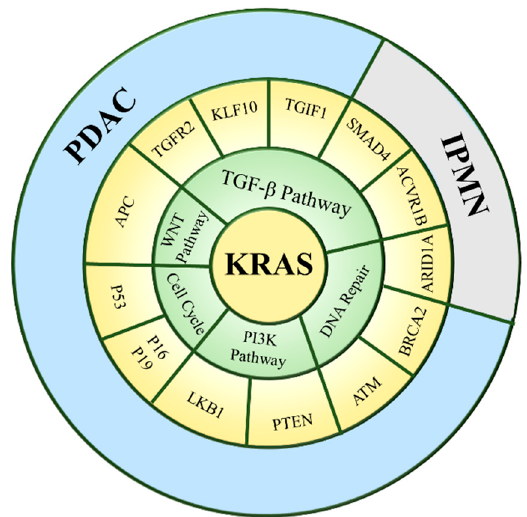
Figure 1. Cross talk of mutant Kras signaling with other altered cellular pathways in pancreatic ductal adenocarcinoma (PDAC). Five core cellular pathways and processes have been identified that are altered through gene mutations with high frequency in PDAC. Thirteen representative mutated genes associated with each pathway are depicted in the outermost circle. The most common mutation of KRAS signaling pathway is located in the center. IPMN: Intraductal papillary mucinous neoplasm.